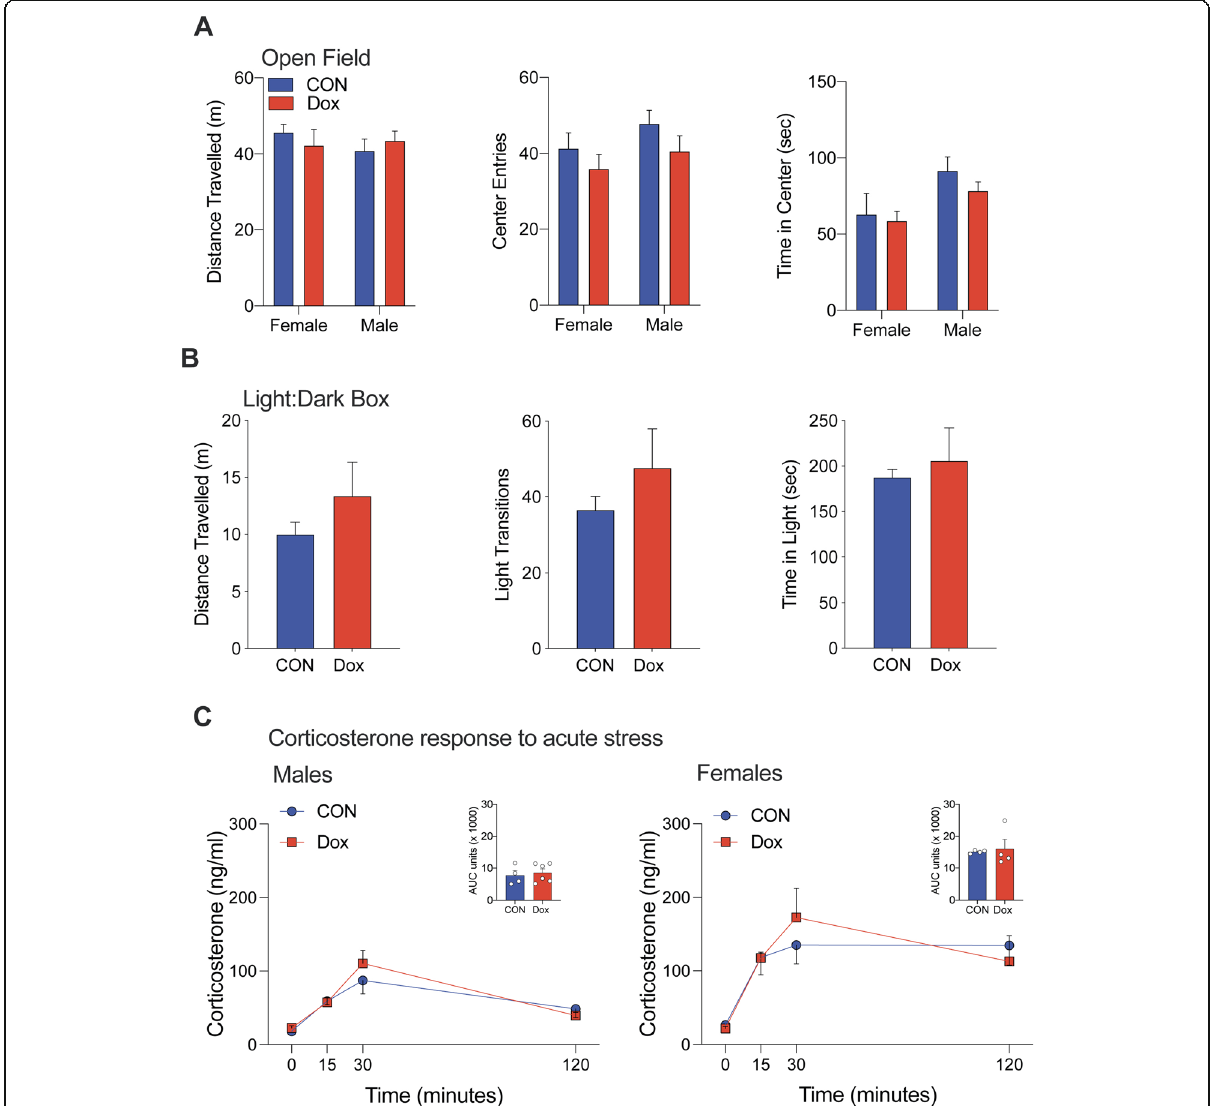
Fig. 2 Motor function, locomotion and response to acute stressors is intact of males and females exposed to doxycycline during development. a ) No effect of developmental exposure to doxycycline on distance traveled, center entries or time in center in the open field in adult males and females. b No effect of developmental exposure to doxycycline on distance traveled, center entries or time in center in the light: dark box in a cohort of adult males. c No effect of developmental exposure to doxycycline on the corticosterone response to an acute restraint stress in adult males and females. 4-6 animals per sex per treatment groups were used for these studies, all p s >